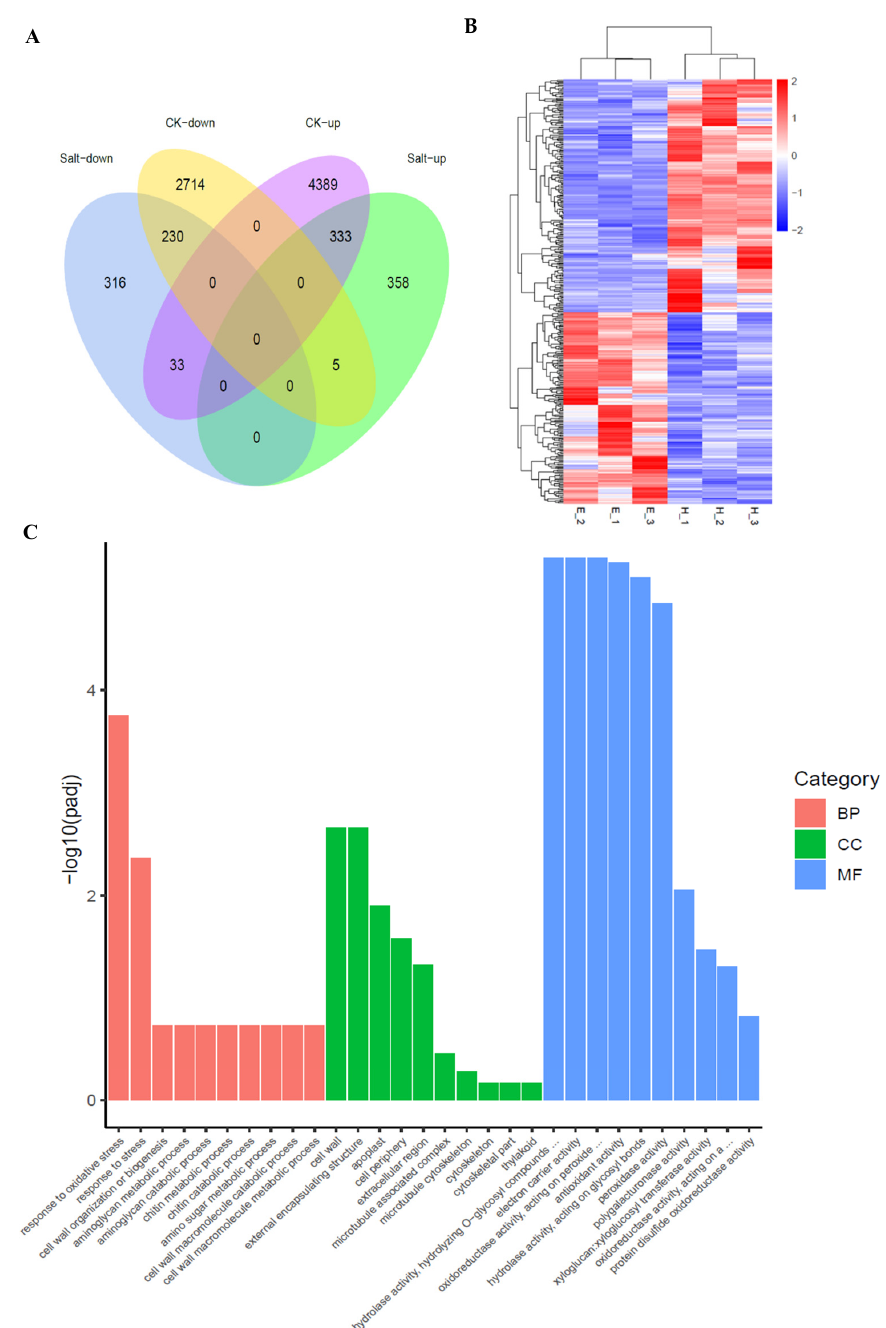
Figure 6. Transcriptome analysis of the OsWRKY54 -regulated genes. ( A ) Venn diagram showing the OsWRKY54 -regulated genes in the oswrky54 mutant and WT. CK-up: up-regulated genes in the oswrky54 mutant compared with WT under normal conditions (fold-change > 2.0). Salt-up: up-regulated genes in the oswrky54 mutant compared with WT under salt stress (fold-change > 2.0). Salt-down: down-regulated genes in the oswrky54 mutant compared with WT under salt stress (fold-change < 0.5). CK-down: down-regulated genes in the oswrky54 mutant compared with WT under normal conditions (fold-change < 0.5). ( B ) Cluster analysis of the OsWRKY54-regulated genes under salinity conditions. E1-E3 are three biological replicates of wild-type plants, and H1-H3 are three biological replicates of the oswrky54 plants. Red: up-regulated; blue: down-regulated. ( C ) GO enrichment description of down-regulated genes in the oswrky54 mutant compared with WT under salt stress. MF (molecular function), CC (cellular component), and BP (biological